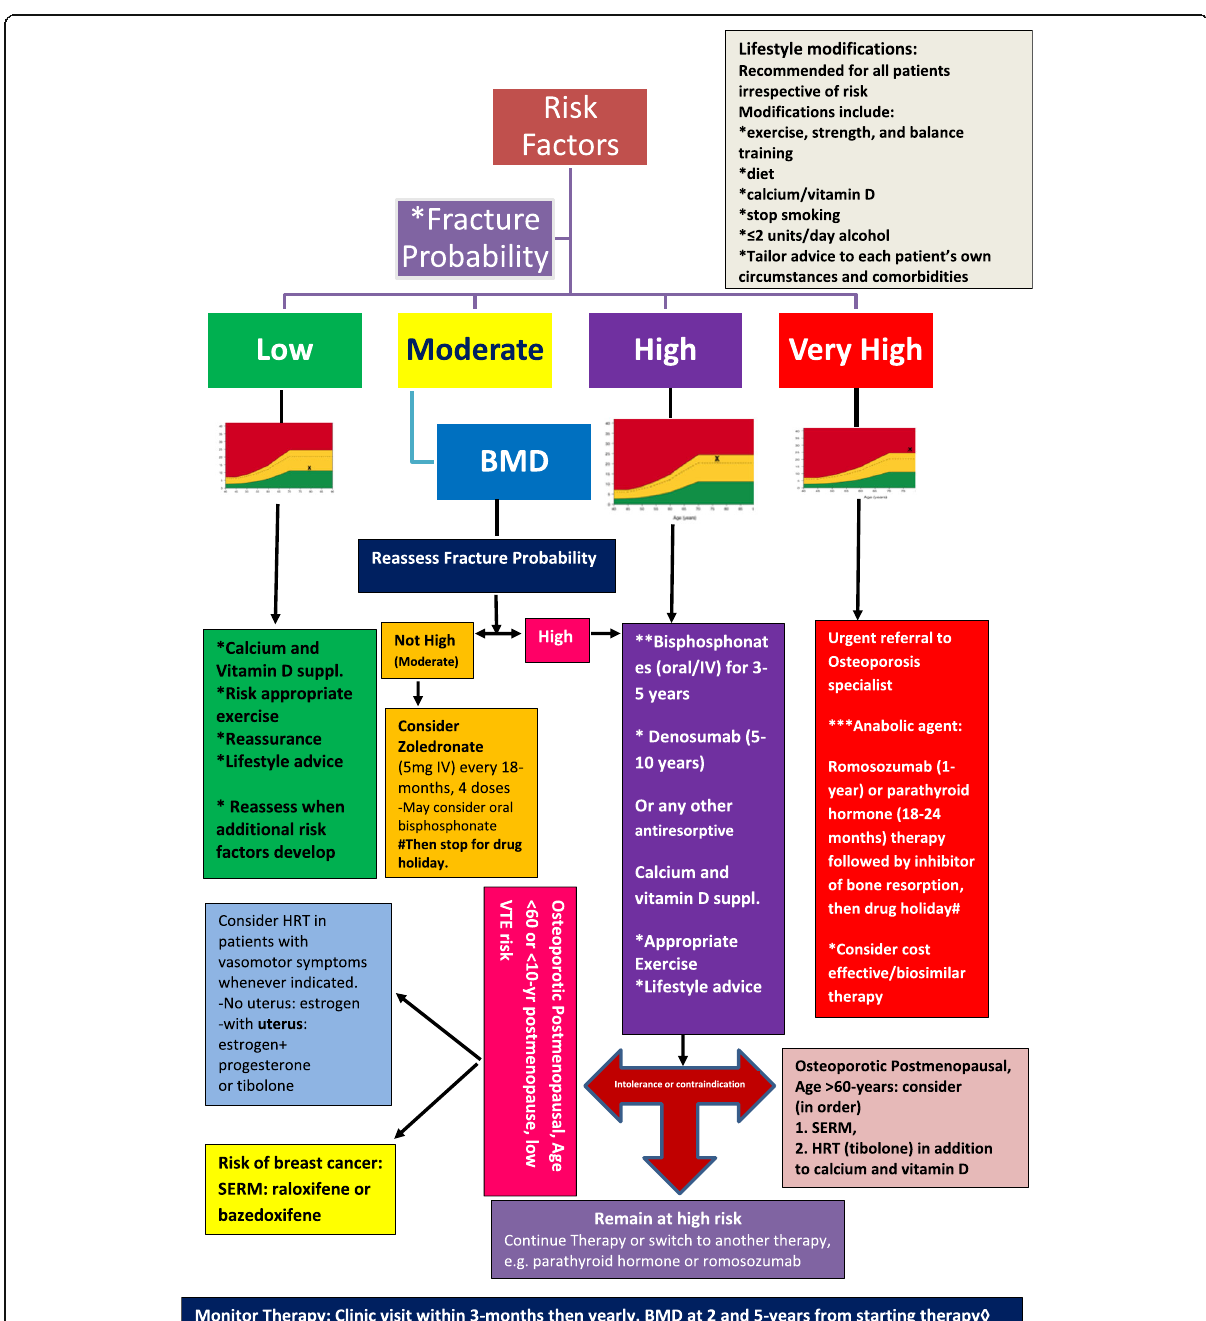
Fig. 1 (See legend on next